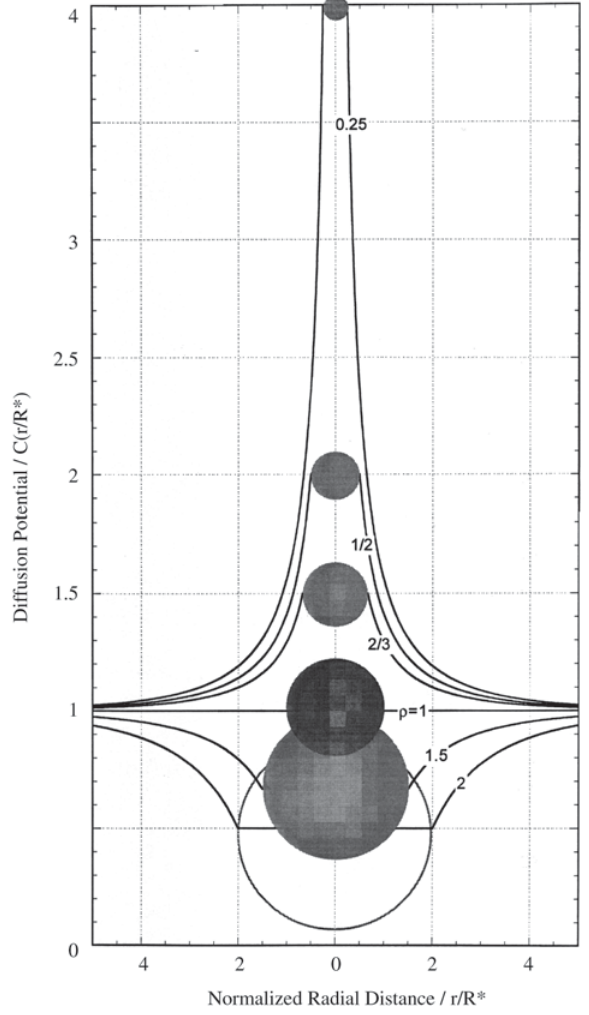
Figure 1. Diffusion fields, C( ζ ; ρ ; V ), based on Debye-Hückel V theory during phase coarsening in a microstructure with a dispersoid volume fraction of V =0.05. The dimensionless potential plotted V here represents the expression for the normalized field, C( ζ ; ρ ; V ) = (1- ρ ) exp( ρ √ 3 V })exp(- ζ √ 3 V )/ ζ +1, where V V V ζ = r/R * is the running (distance) variable. Each field is labeled by the value of the scaled particle radius, ρ ≡ R/R * , with which it is associated. Note that the field gradients are negative for particles less than critical size ( ρ ≤ 1), and positive for particles greater than critical size ( ρ ≥ 1). The critical sized particle ( ρ =1) is shown sur- rounded by a constant field (zero gradient) at the average diffusion potential, C =1, in the matrix ∞